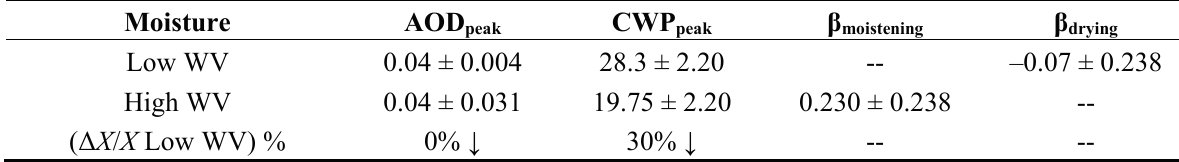
Figure 12. Response of cloud water path (CWP) to increasing aerosol optical depth (AOD) for low and high atmospheric WV environments for AADR_Sahara. Table 6. Percent of decrease ( ↓ ) in the characteristics parameters of cloud water path response curve to aerosol induced perturbation from low to high water vapor environment AADR_Sahara Drying is the highest sensitivity mechanism in low water vapor environment while moistening is the highest sensitivity mechanism in high water environment.